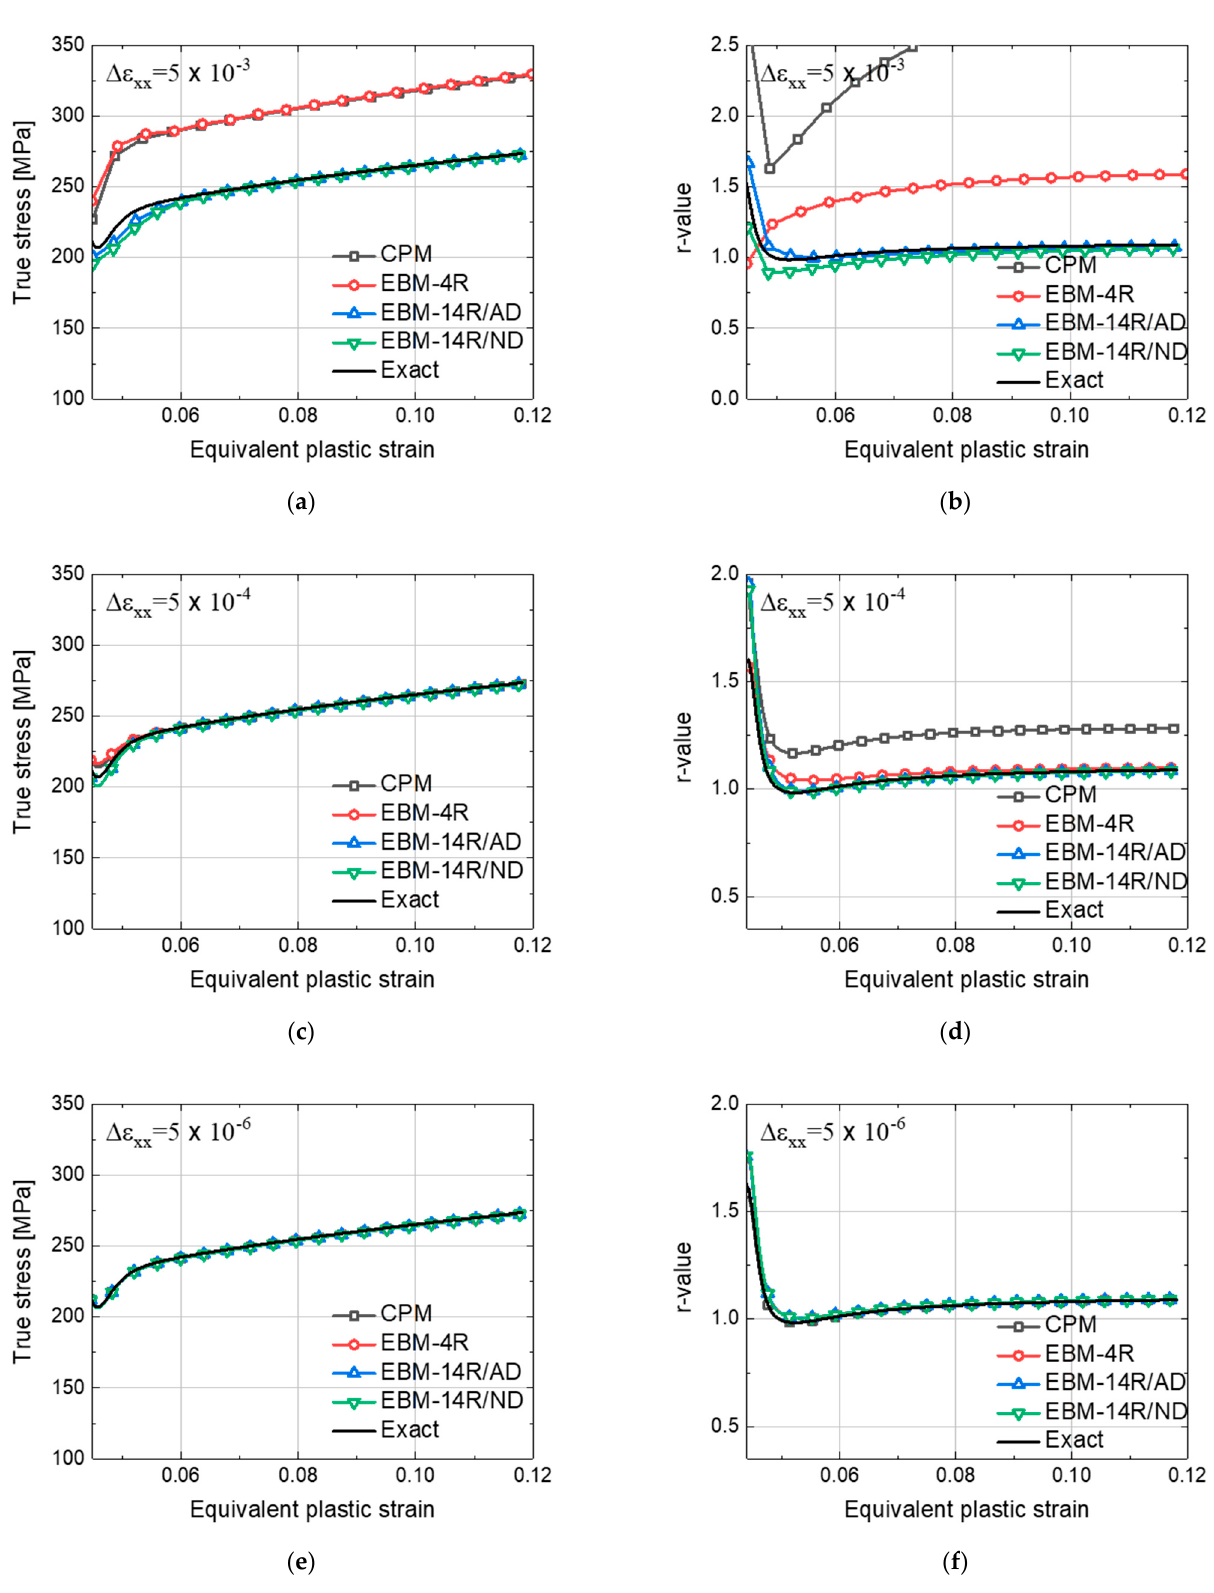
Figure 9. The evolution of the flow stresses and r-values of MAT 1 under C5T10CR path for different stress integration algorithms with strain increments: ( a , b ) ∆ ε xx = 5 × 10 − 3 , ( c , d ) ∆ ε xx = 5 × 10 − 4 and ( e , f ) ∆ ε xx = 5 × 10 − 6